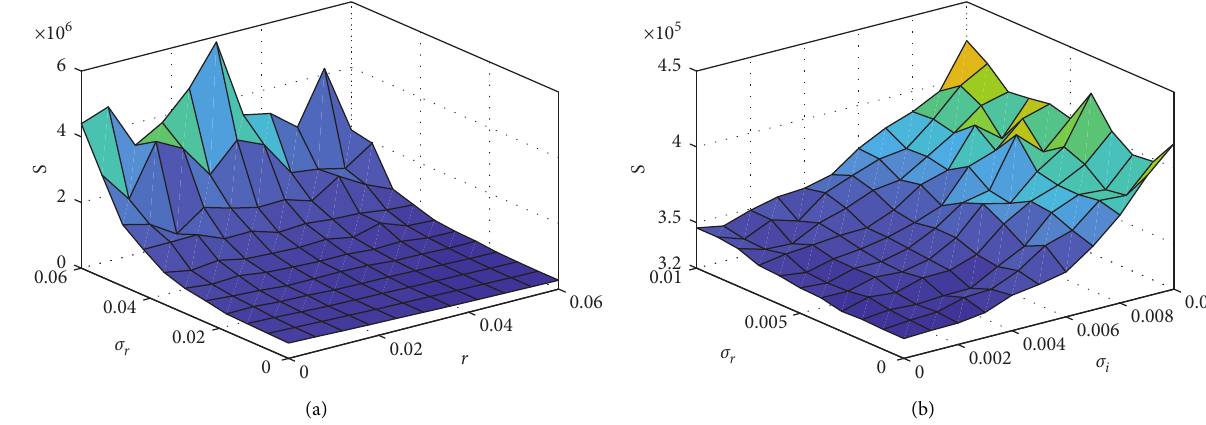
Figure 10: Present value of subsidies S (unit: CNY 100,000) based on (a) σ